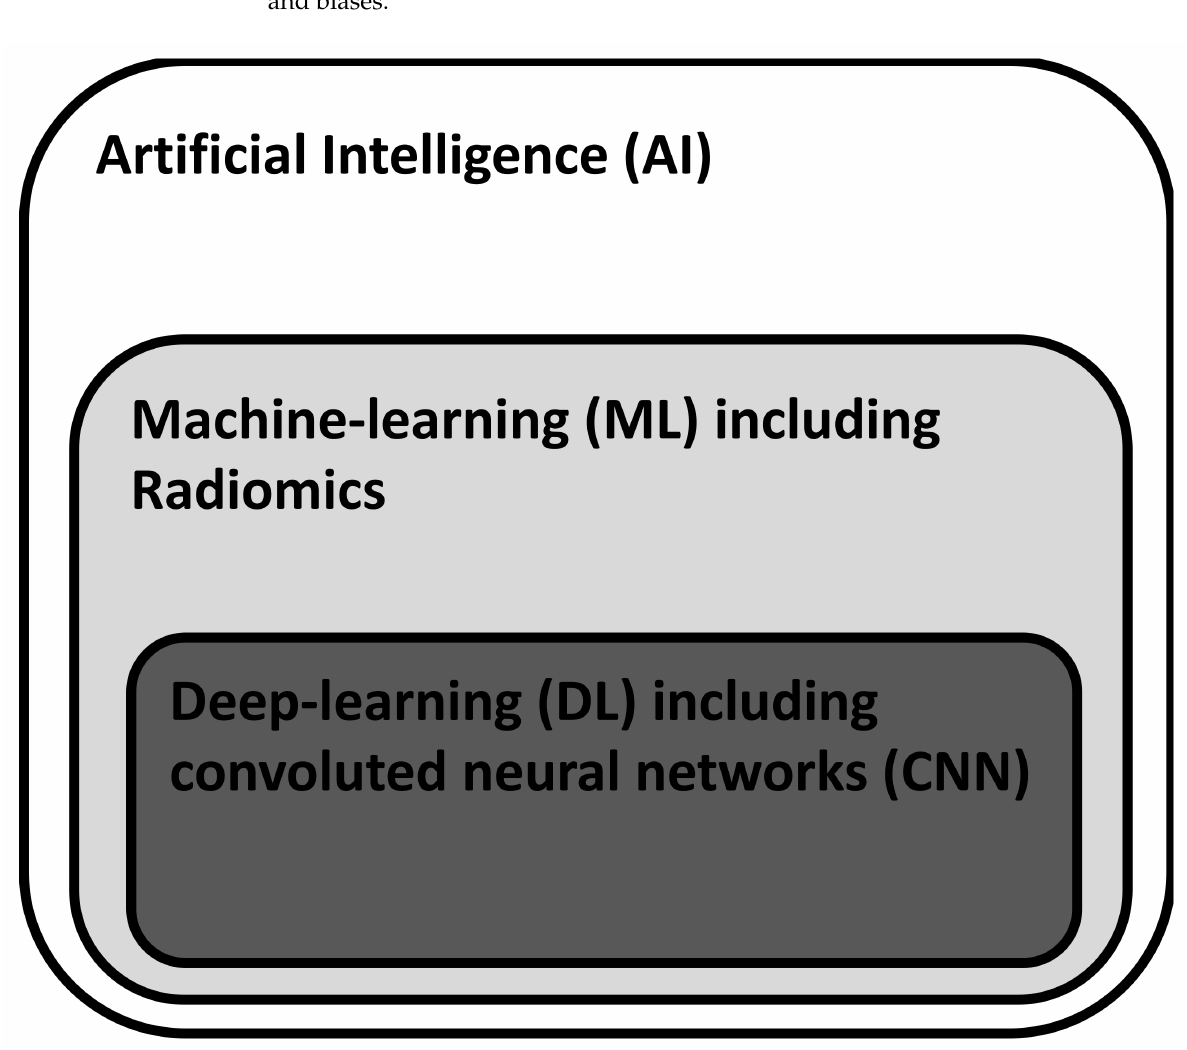
Figure 2. Hierarchical structure of AI-techniques. Whereas ML requires human feature engineering as guidance for learning, DL is based on self-learning algorithms that can detect and process simple and complex image